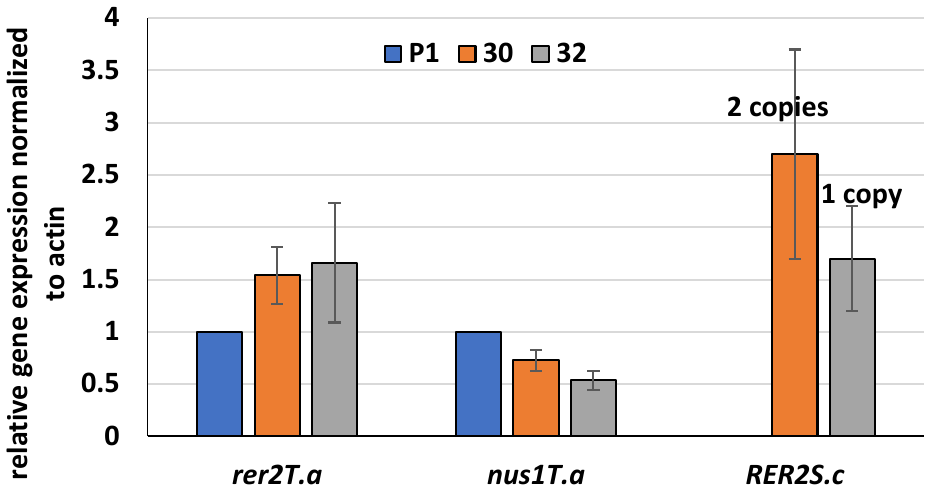
Figure 2. Transcript levels of RER2 genes from S. cerevisiae ( RER2S.c ) and T. atroviride ( rer2T.a ) and nus1 subunit of cis -prenyltransferase ( nus1T.a ) determined by RT-qPCR in the RER2 transformed T. atroviride . Trichoderma strains (30—RER30/11; 32—RER32/11) and control strain P1 were grown for 144 h in PDB medium, RNA was extracted and cDNA synthesized. qPCR reactions were per- formed using a LightCycler 96 instrument. The amplification and melting curve data were collected and analyzed using the LightCycler96 ® software 1.0. Data were obtained from three independent experiments, each determined in triplicate. Expression of the native rer2 gene in the transformed strains was normalized to rer2 expression in the control strain P1.